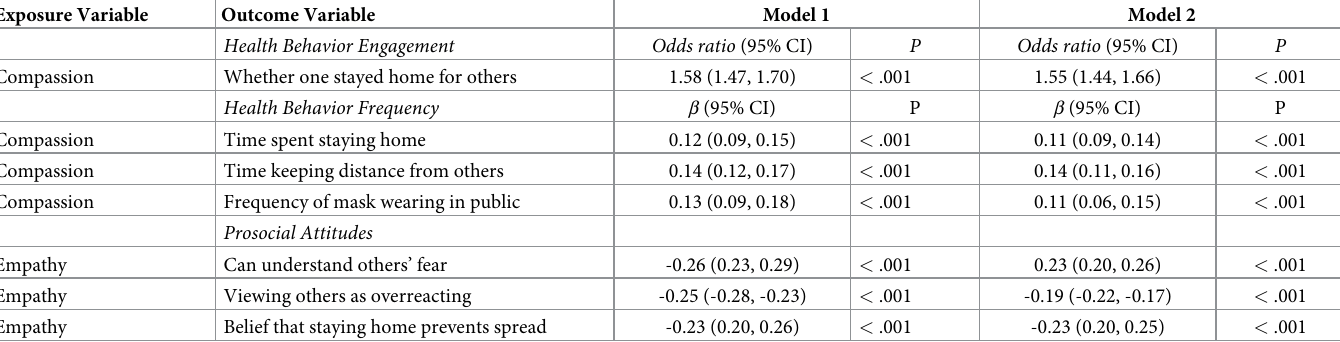
Table 2. Standardized odds ratios and regression coefficients for dispositional compassion and empathy in relation to health behaviors and prosocial attitudes, in models with and without political